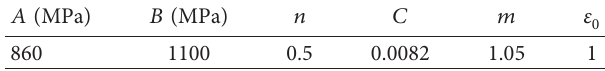
Table 2: Parameters of J-C model of Ni-based alloy